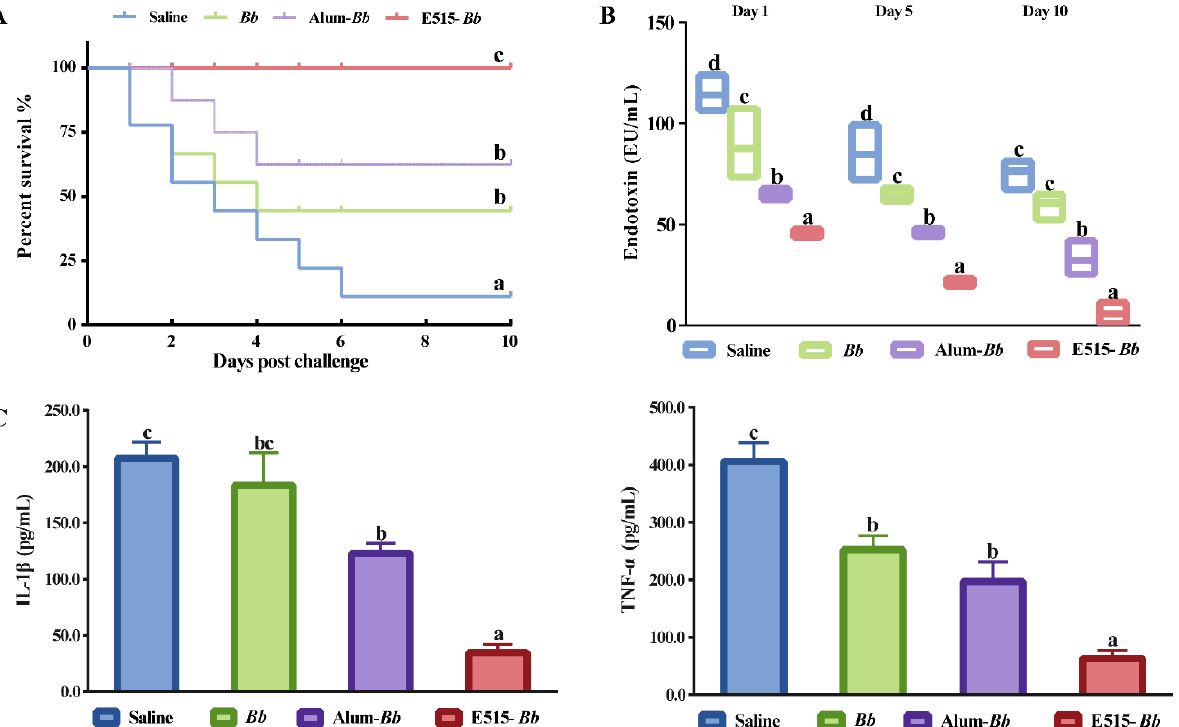
Figure 3. Protective effect of the E515- Bb vaccine post Bb challenge. Rabbits ( n = 9/group) were chal- lenged 4 weeks after boosting by ear vein injection with live Bb (2.4 × 10 10 CFU/rabbit). The animal survival rate was monitored over the next 10 days ( A ), the serum level of endotoxin was detected 1, 5, and 10 days after infection ( B ), and the serum levels of IL-1 β and TNF- α were determined 24 h after infection ( C ). Data are presented as the mean ± SE. Bars labeled with different lowercase letters (e.g., “a” and “b”) are significantly different ( p < 0.05), and bars labeled with same or common low- ercase letters are not statistically different (e.g., “a” and “ab”), ( p ≥ 0.05).